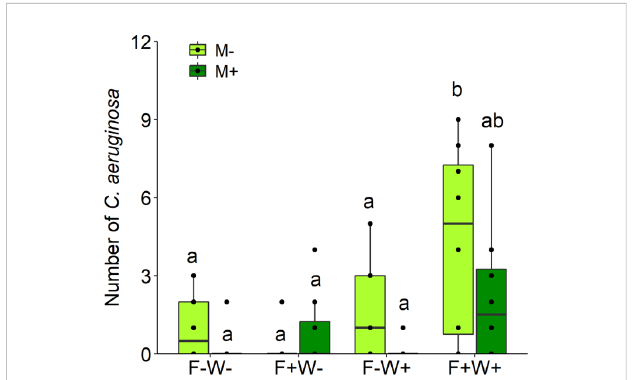
FIGURE 6 Abundance of the insect species Chrysolina aeruginosa on the aerial tissues of Artemisia ordosica that were inoculated with the AM fungal species Funneliformis mosseae (AMF+) or not (AMF-) and grown under four different combination of fertilization (F-: no fertilization; F+: fertilization) and water addition (W-: low soil water; W+: high soil water) treatments. Light symbols: plants received no AMF; dark symbols: plants inoculated with AMF Funneliformis mosseae . The boxplot shows the 25% and 75% quartiles, the median, whiskers (1.5 times the interquartile range) and the outliers of the samples, and the points in the plot area represent different replicates of the corresponding treatment. Boxplots sharing one or more identical letters are not signi fi cantly different based on Tukey ’ s post hoc test. Statistics are shown in Table